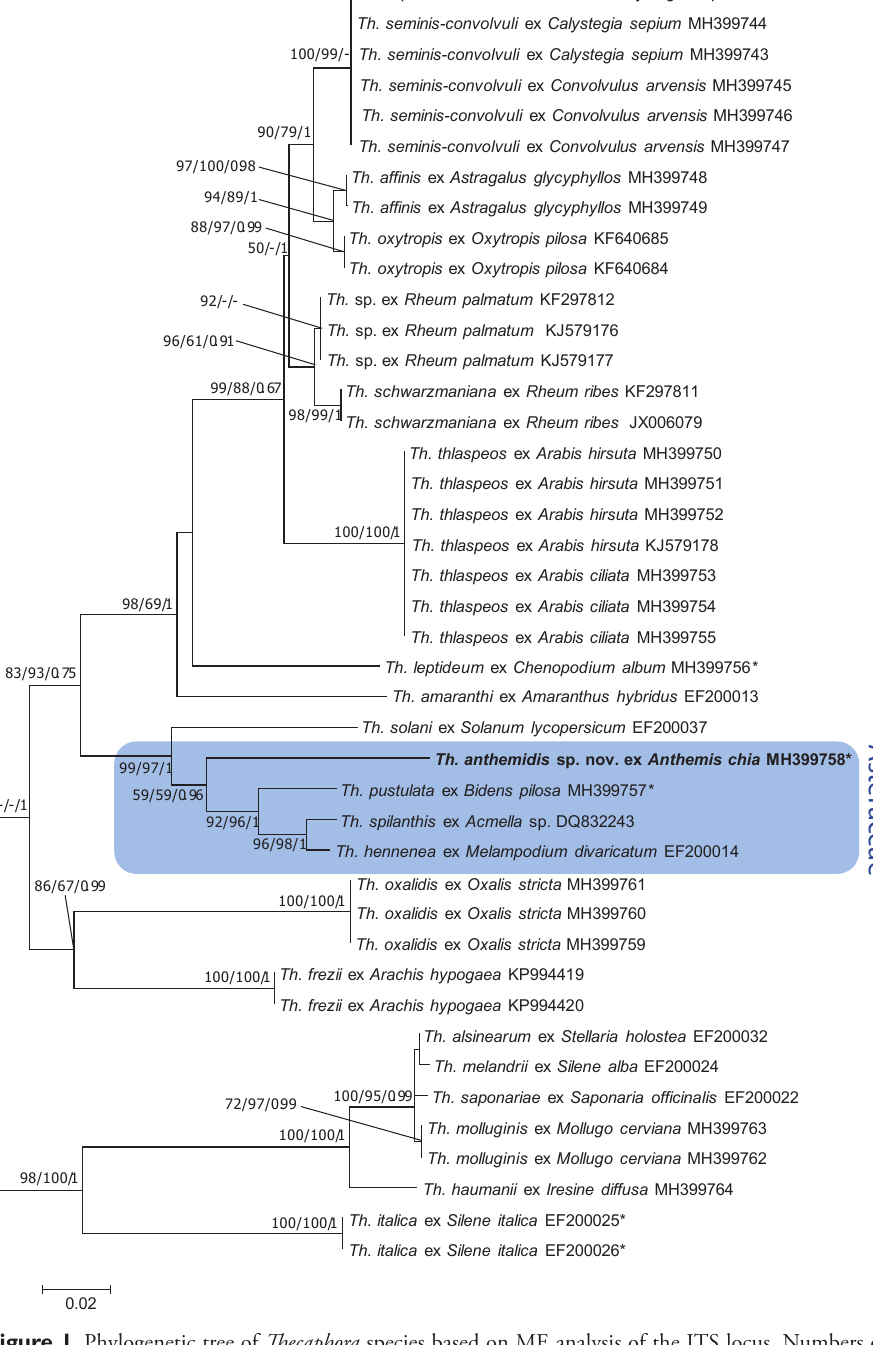
Figure 1. Phylogenetic tree of Thecaphora species based on ME analysis of the ITS locus. Numbers on branches denote support in ME, ML and BA, respectively. Values below 50% are denoted by ‘–‘. The bar indicates the number of substitutions per site. Ex-type sequences are highlighted with an